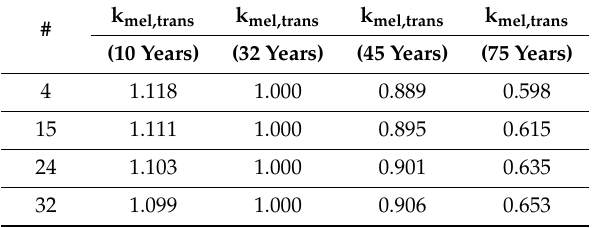
Table 6. Age-dependent correction factor for lens transmission at four ages calculated for four LEDs. k mel,trans k mel,trans k mel,trans k #